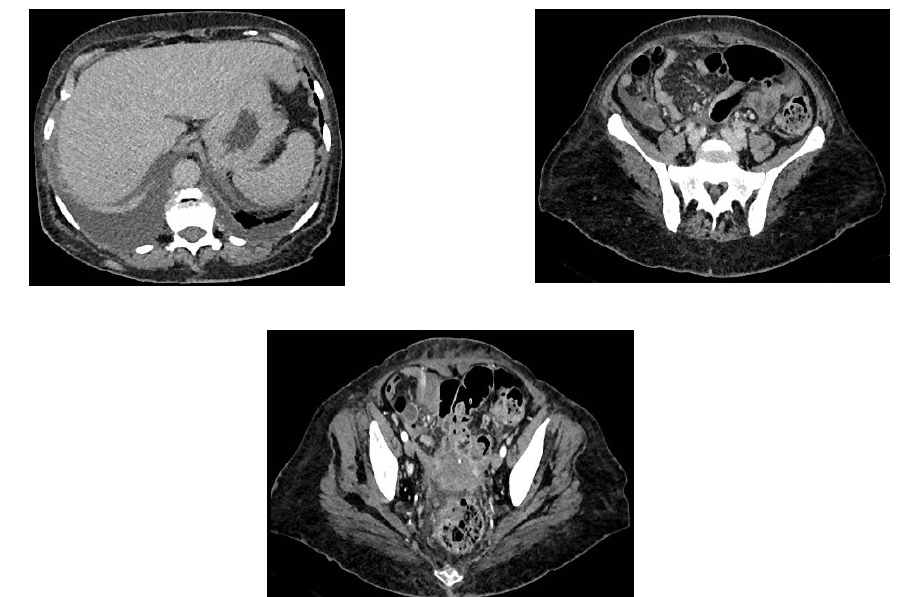
Figure 4. CT images showing peritoneum disease progression.